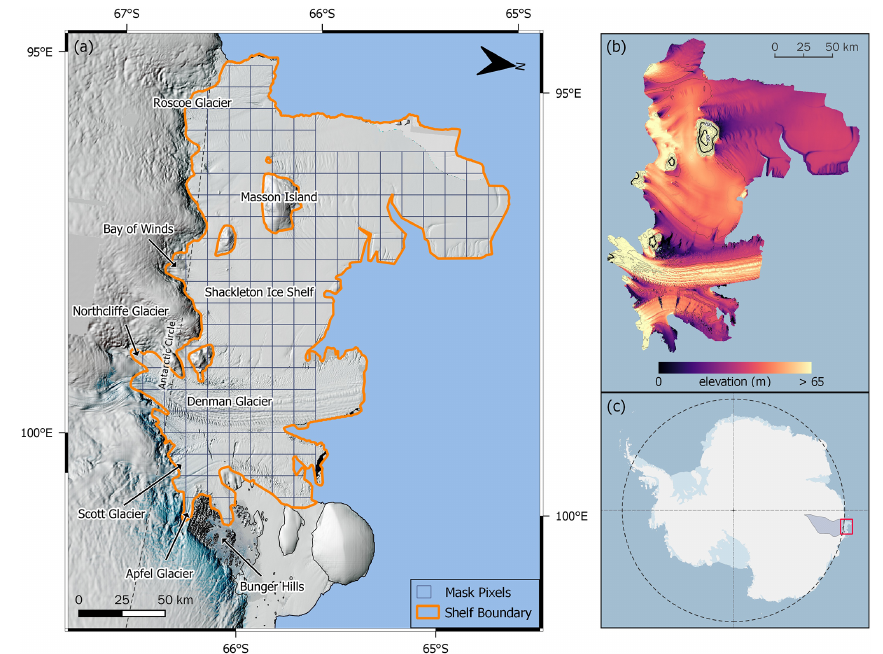
Figure 1. (a) Geographic setting of the Shackleton Ice Shelf. The background image shows LIMA imagery (2000–2003) (Bindschadler et al., 2008) overlain on REMA topography (Howat et al., 2019); the shelf boundary is taken from the MEaSURES dataset (Mouginot et al., 2017). (b) Surface elevation of the Shackleton Ice Shelf using REMA topography; contour lines are shown at elevations of 10m (light grey), 40m (black), and 200m (thick black). (c) Location of the Shackleton Ice Shelf in Antarctica; the basin which drains through the shelf is also shown. Figure created using Quantarctica (Matsuoka et al.,